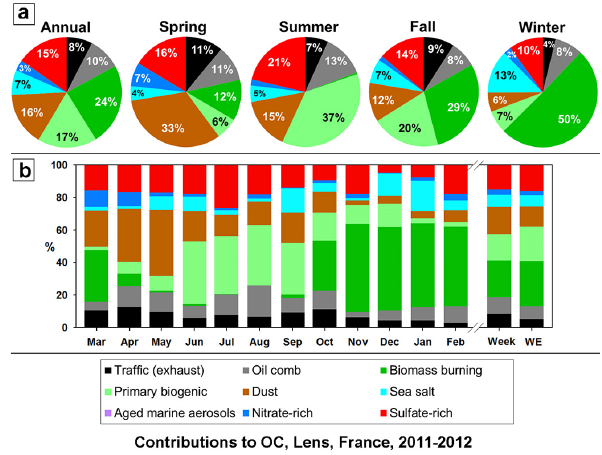
Fig. 9. Contributions of the identified sources in % to total OC mass concentration for the year 2011–2012, spring, summer, fall and win- ter.